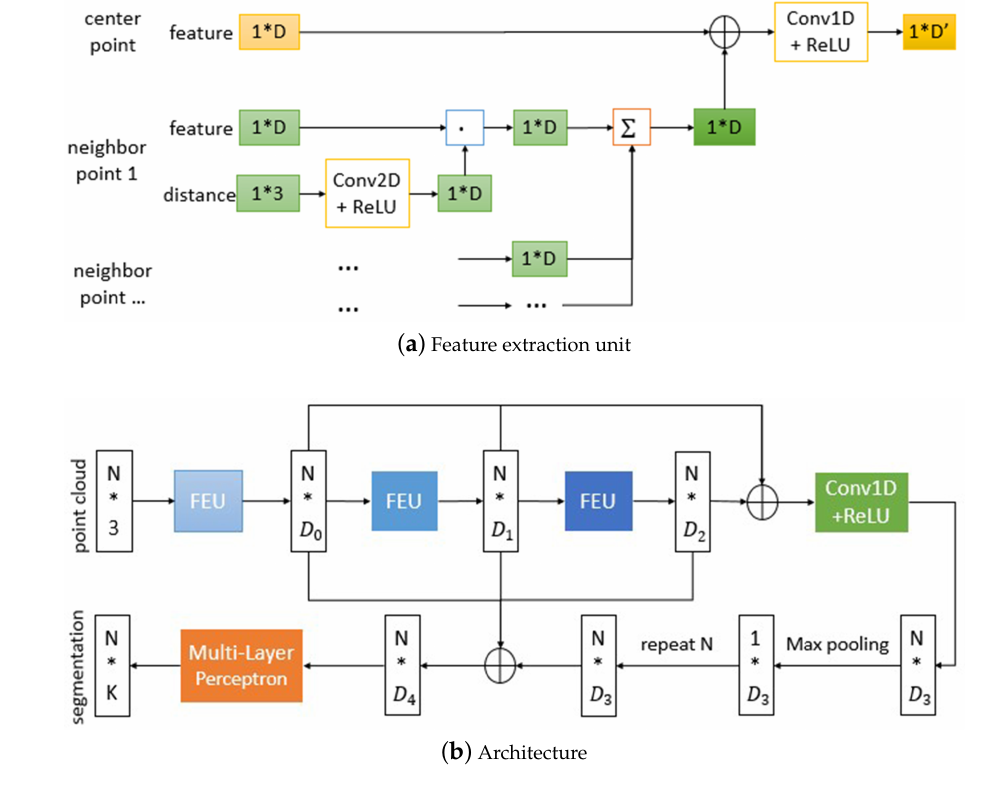
Figure 9. Segmentation